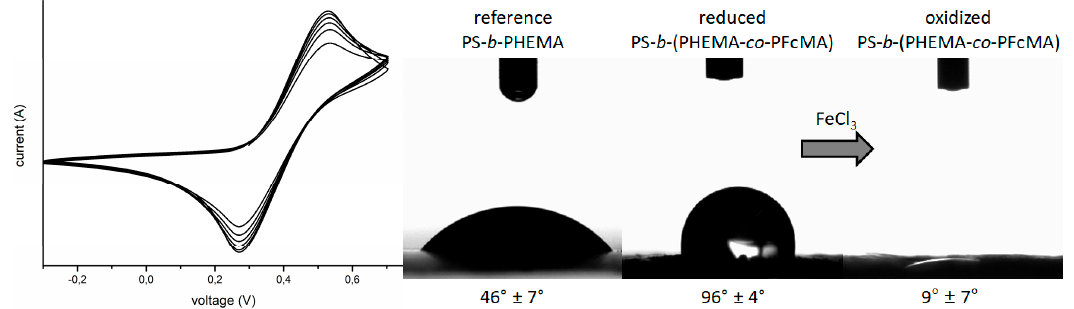
Figure 6. Left : Cyclic voltammogram for a PS 60 – b –(PHEMA 13 – co –PFcMA 27 ) 123 as thin film. Shown are five cycles at a rate of 20 mV·s − 1 ; Right : Contact angles obtained for a reference membrane consisting of PS- b -PHEMA and of the ferrocene functioanlized membranes in a reduced and oxidized state. As a result, the ferrocene-functionalized membrane revealed higher CA values (96 ◦ ± 4 ◦ ) than the PS- b -PHEMA reference membrane (46 ◦ ± 7 ◦ ). This is caused by the more hydrophobic character of